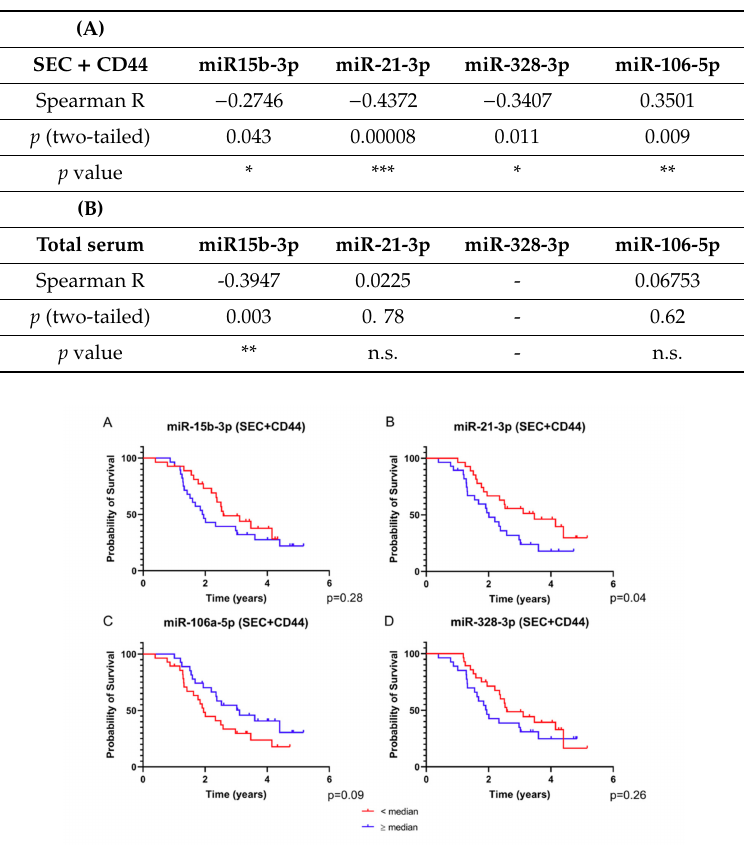
Table 1. Correlation of the survival of 55 patients with microRNA levels from SEC + CD44 EV ( A ) or total serum ( B ) using the Spearman’s rank correlation coe ffi cient, r. Depicted are the Spearman r values showing either a positive or negative correlation, the p value, and the degree of significance (* p < 0.05, ** p < 0.01, *** p < 0.001, n.s. = not significant). For miR-328-3p in total serum, no correlation with survival was calculated because 53% of the values were non-measurable.